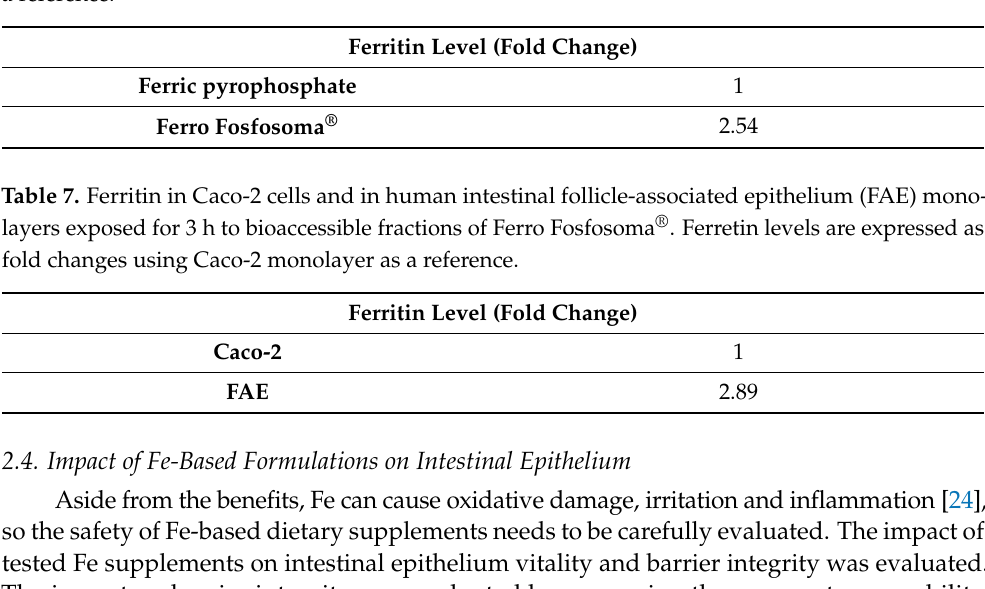
Table 6. Ferritin in Caco-2 cell monolayer exposed for 3 h to bioaccessible fractions of the two Fe formulations. Ferritin levels are expressed as fold changes using Ferric pyrophosphate salt as a reference.